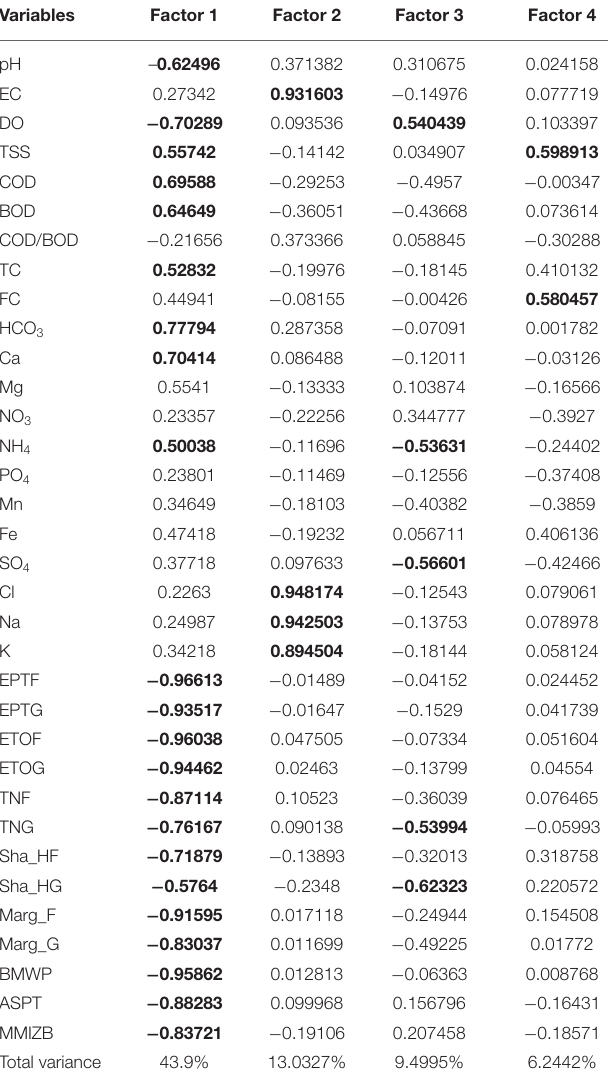
TABLE 4 | Correlation between the first four factors and observed variables (factor